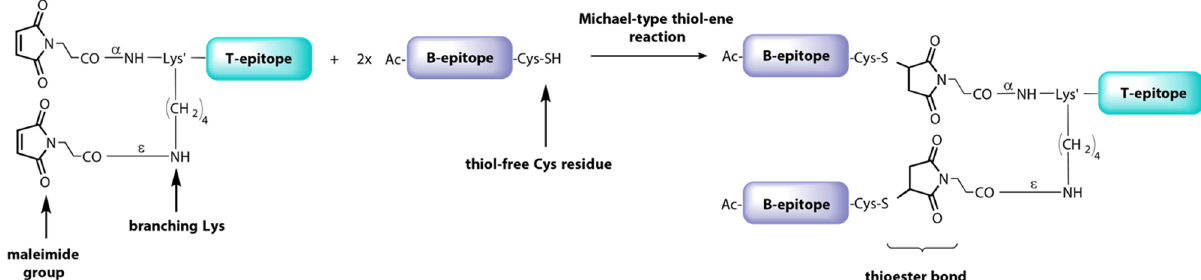
Figure 6. Synthetic scheme of the B 2 T vaccine prototype against FMDV.